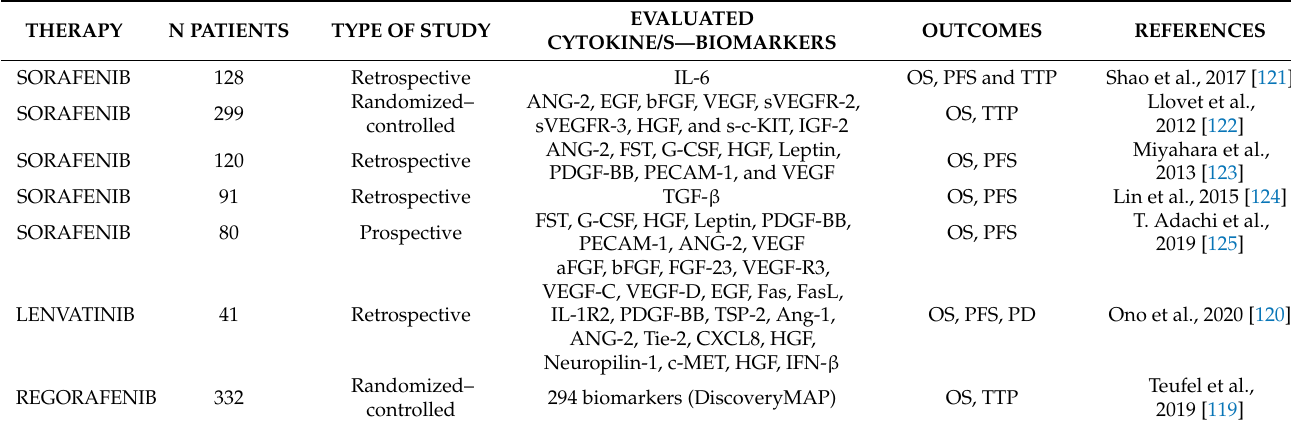
Table 1. Evaluation of serum biomarkers with potential prognostic value in systemic HCC